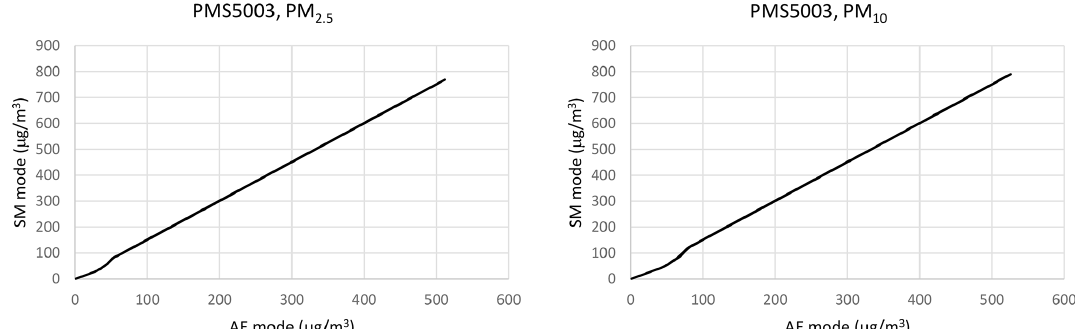
Figure 2. AE and SM modes of the PMS5003